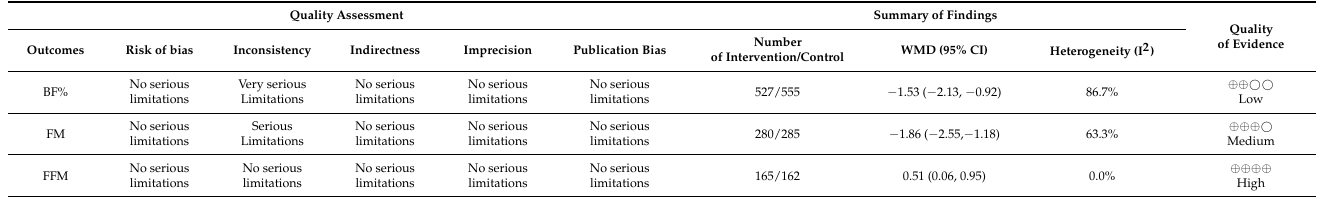
Table 4. GRADE profile of the effect of high-intensity interval training type on body fat percentage and fat-free